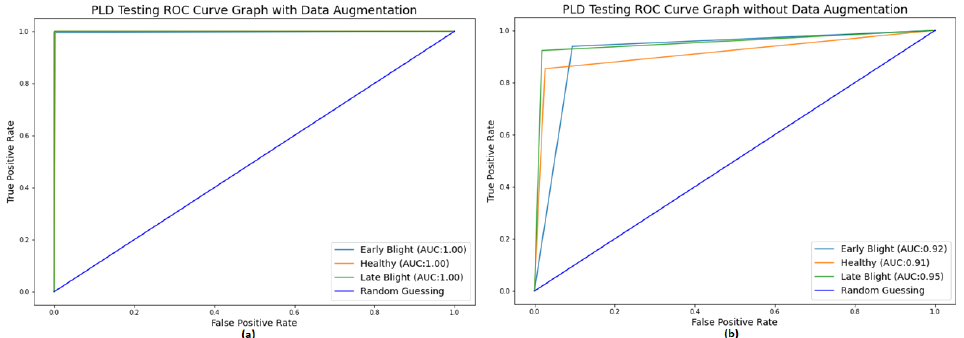
Figure 9. ( a ) The confusion matrix of PDDCNN on PLD with augmentation. ( b ) The confusion matrix of PDDCNN on PLD without augmentation.